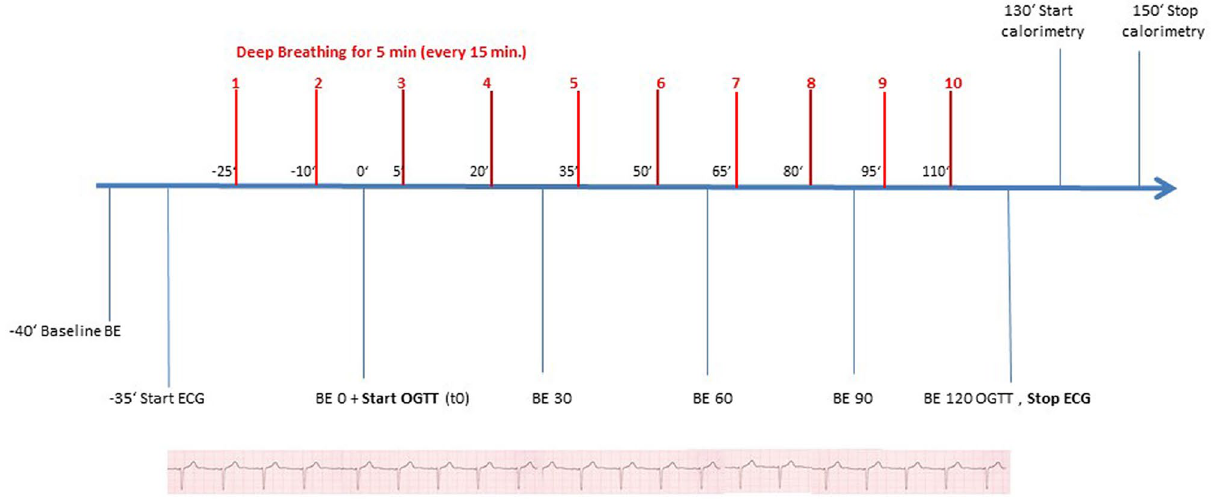
Figure 2. Schematic overview of the experiment. Baseline blood samples were obtained at time point − 40, OGTT was started 40 min after the first blood extraction (BE) and stopped 120 min after ingestion of the glucose solution. ECG recordings were performed 35 min before the start and during the OGTT. Slow deep breathing maneuvers and normal breathing respectively, were performed 25 min before the start of the OGTT for a duration of 5 min with 10 min breaks between each maneuver. Energy expenditure was measured after the end of the